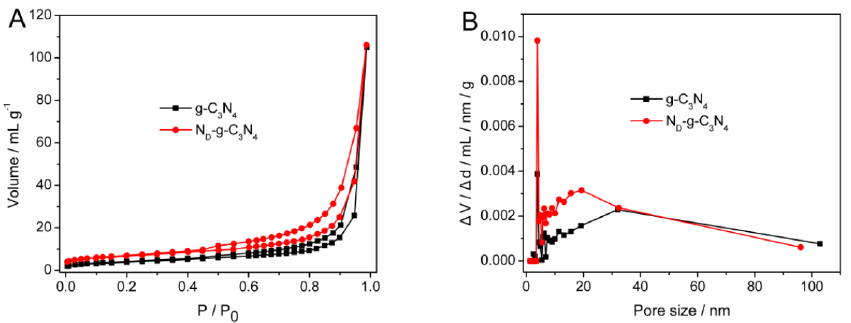
Figure 5. ( A ) N 2 adsorption/desorption isotherms and ( B ) BJH pore size distribution curves of g-C 3 N 4 and N D -C 3 N 4 .